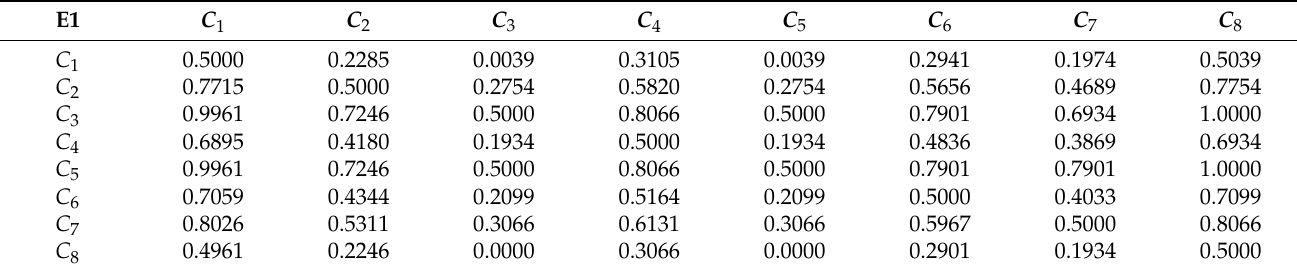
Table 5. Linear solution for transformation matrix of